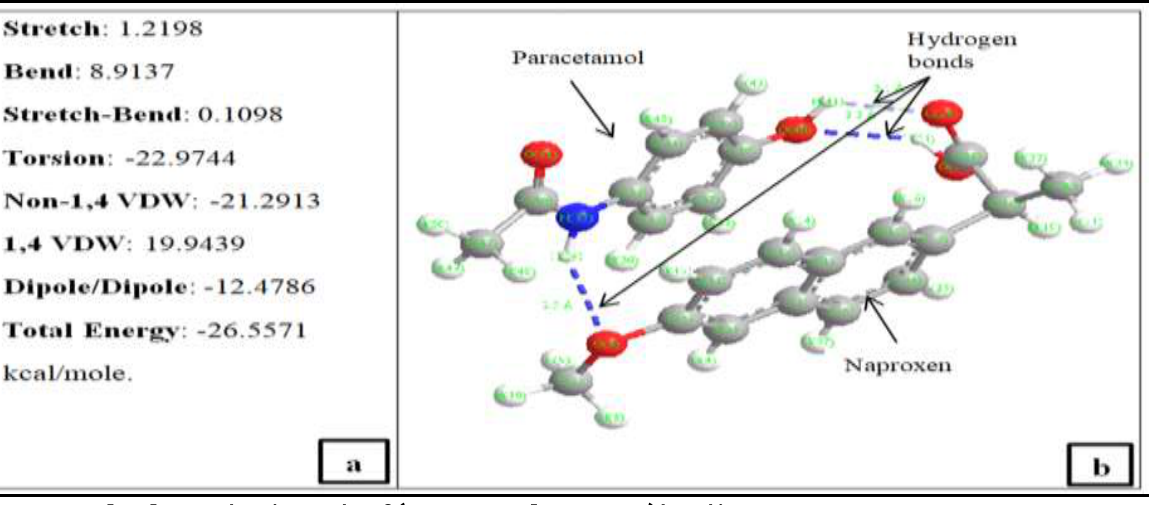
Figure 1. Molecular mechanics study of (paracetamol-naproxen) bonding. a)Theorotical calculation of (paracetamol-naproxen) bonding